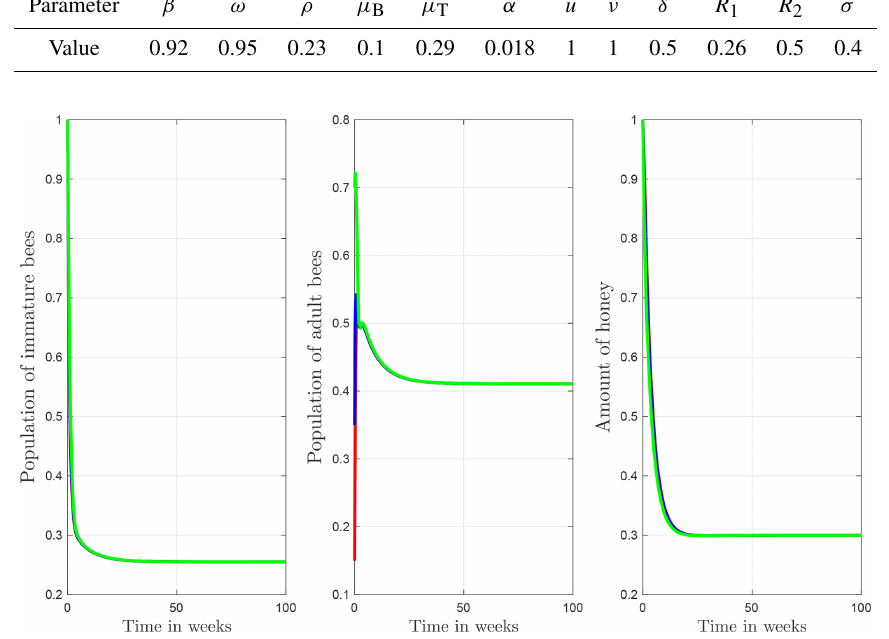
Figure 7. Trajectories for B , T and M . Here the initial condition is ( B (0) ,T (0) ,M (0)) = (1 , 1 , 1) and β = 0 . 9, ω = 0 . 95, ρ = 0 . 23, µ B = 0 . 1, µ T = 0 . 29, α = 0 . 018, u = 1, ν = 1 and δ = 0 . 5. The ecological threshold is λ ∗ = 1 . 2063.